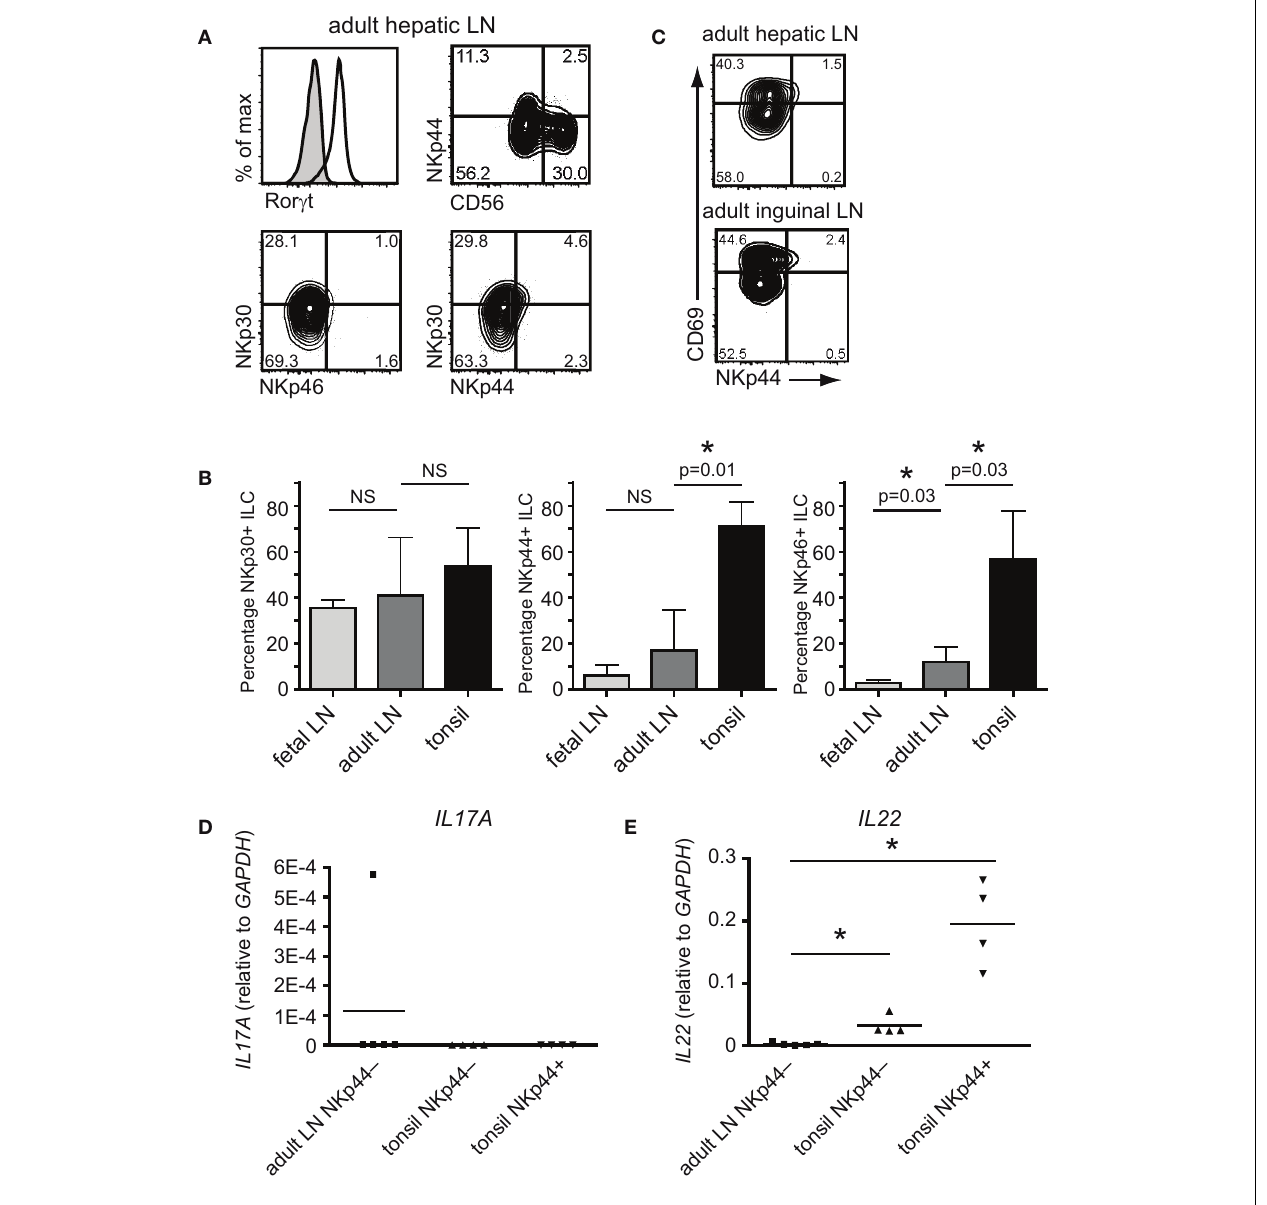
(C) Percentage of NKp30, NKp44 and NKp46 expressing RORC + ILC in fetal lymph nodes, adult-lymph nodes and tonsil (representative example of at least three independent experiments). (D) PCR analysis for IL17A and (E) IL22 transcripts of sorted ILC from adult hepatic lymph nodes compared